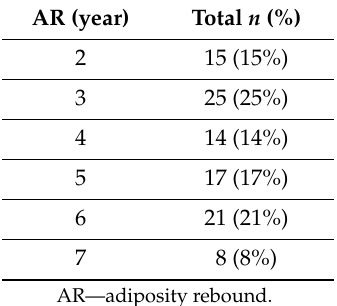
Table 4. Adiposity rebound distribution per years.